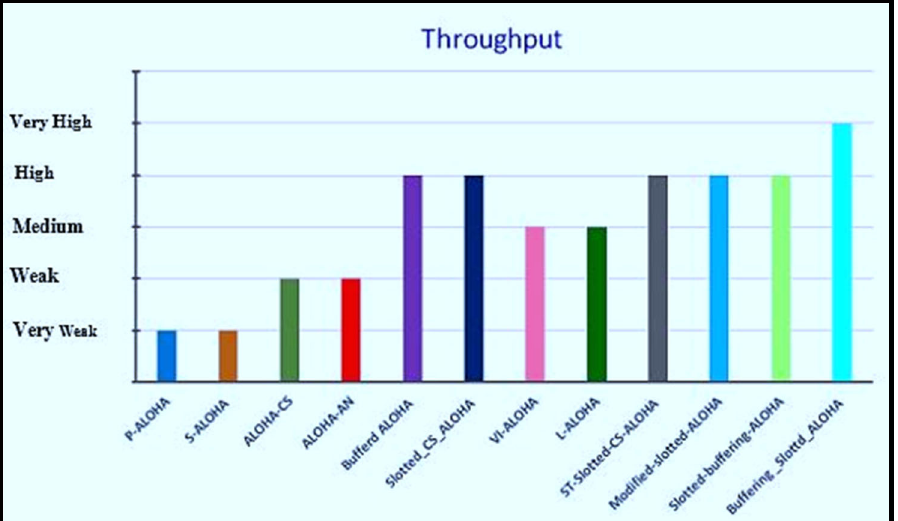
Figure 11. Comparison of throughput between different ALOHA protocols.